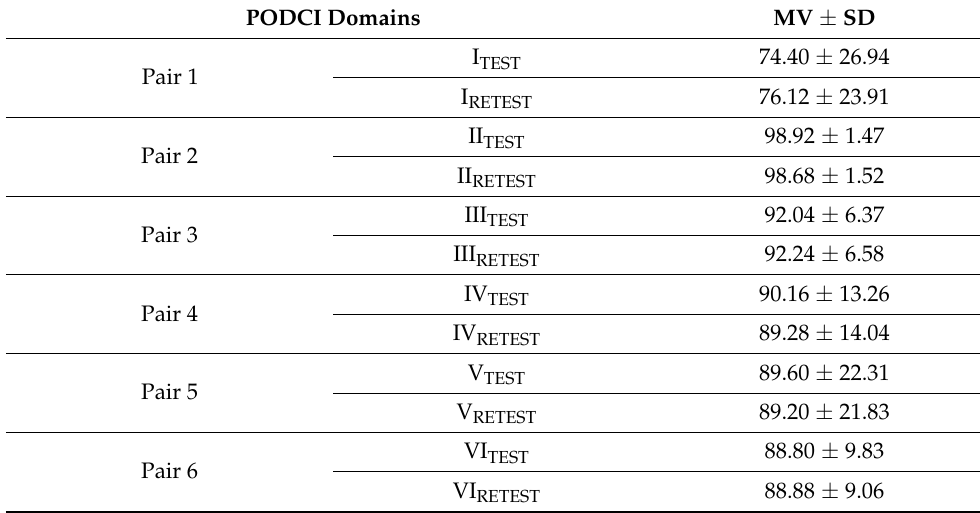
Table 6. Temporal stability due to the patients’